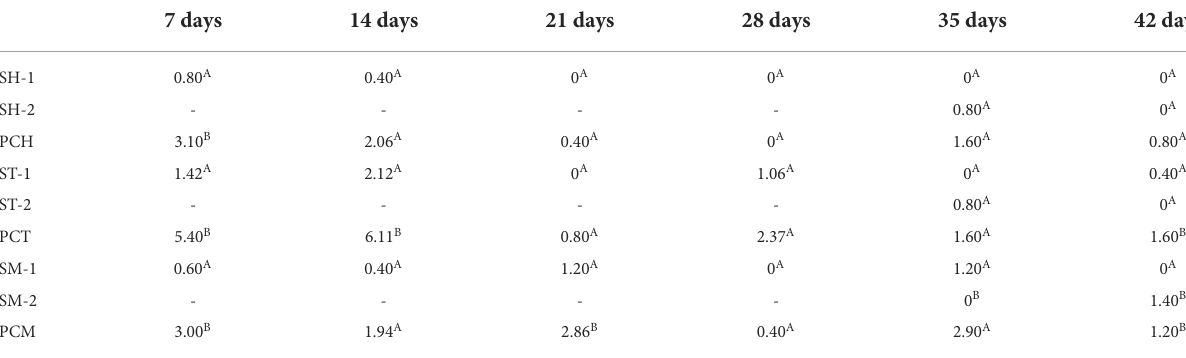
TABLE 1 Bacterial numbers of SH, ST and SM in cecal